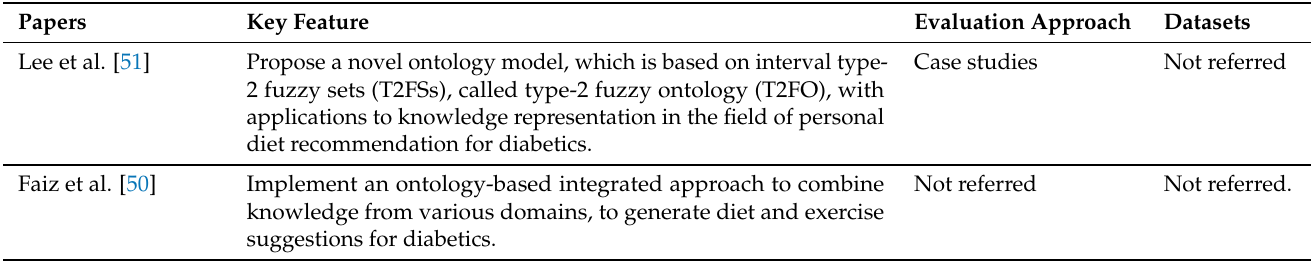
Table 1. Summary of the identified related works using semantic